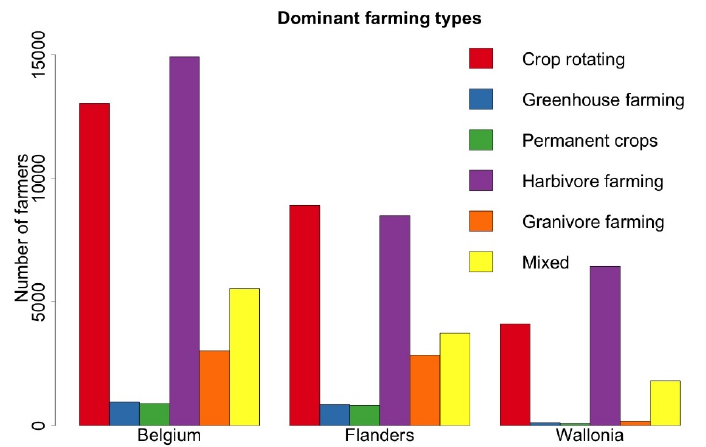
Figure 6. Number of farmers of each type in Belgium, Flanders, and Wallonia.